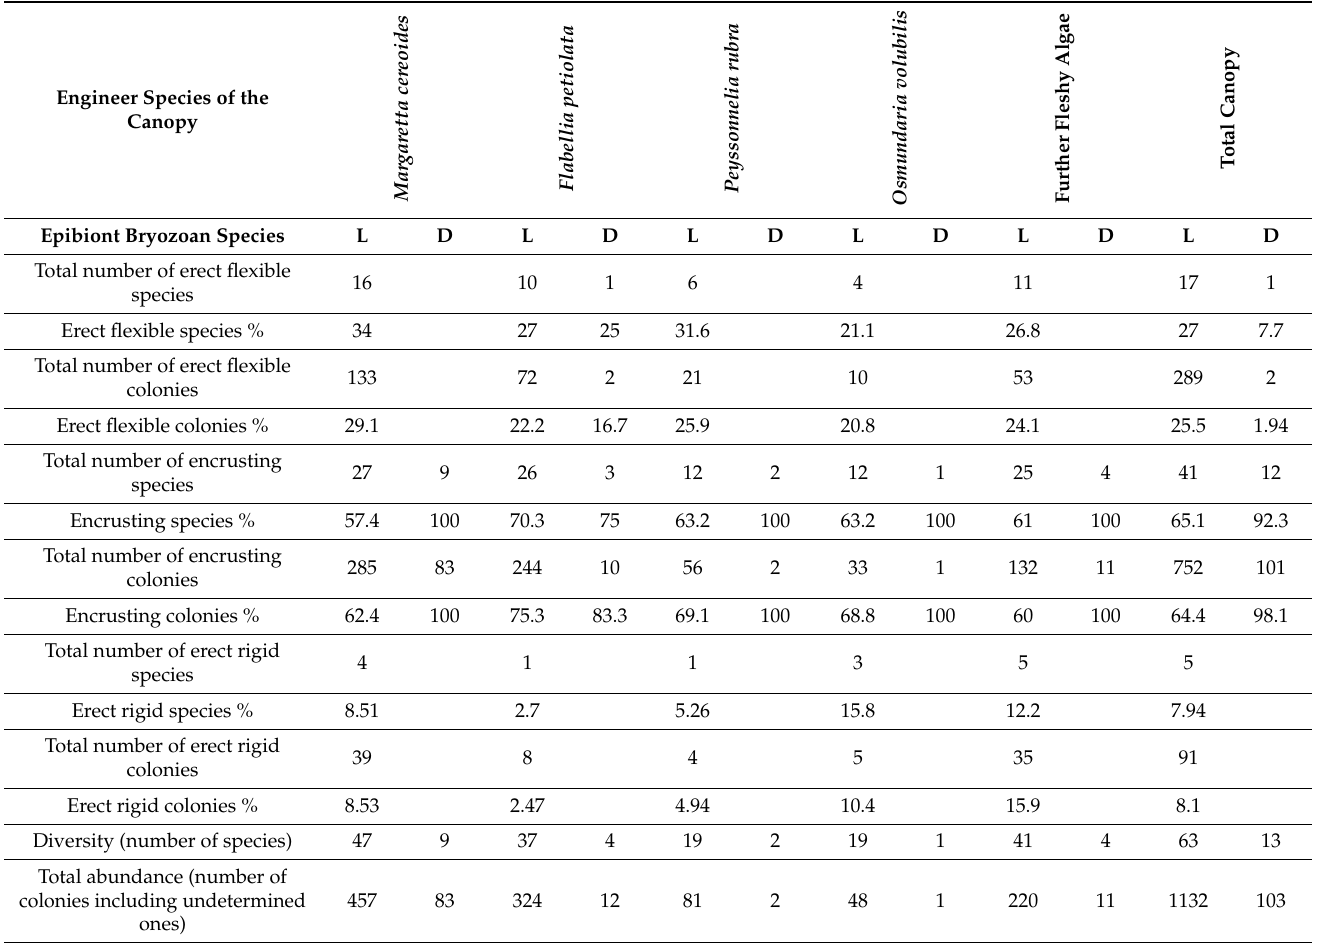
Table 3. Relevance (numbers and relative percentages) of the different growth morphologies devel- oped by epibiont bryozoans found on the bryozoan Margaretta cereoides and main algae of the canopy of the build-up E collected offshore of Marzamemi (Ionian Sea). Note that morphotypes have been grouped in only three main types for the sake of